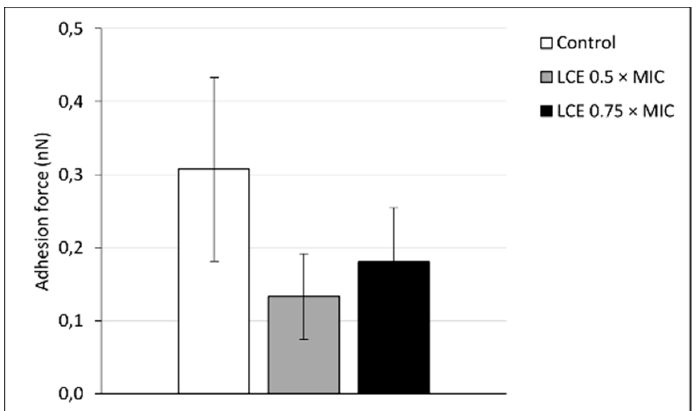
Figure 2. Changes of S. aureus 8325-4 adhesive properties after exposure to L. cardiaca L. extract (LCE) at 0.5 × MIC or 0.75 × MIC for 24 h, measured using atomic force microscopy (AFM). Statistical analysis was estimated with nonparametric Kruskal–Wallis one-way ANOVA test. The differences were significant in comparison to the control ( p < 0.001).